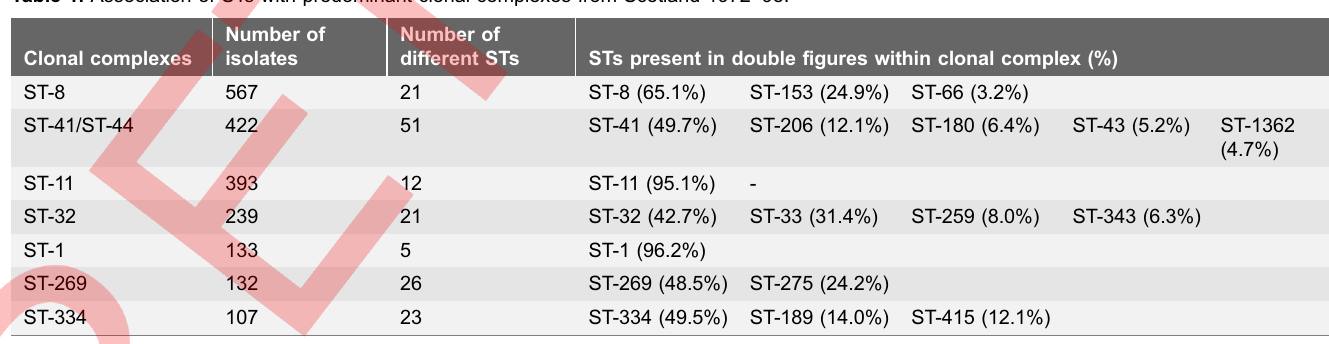
Table 1. Association of STs with predominant clonal complexes from Scotland